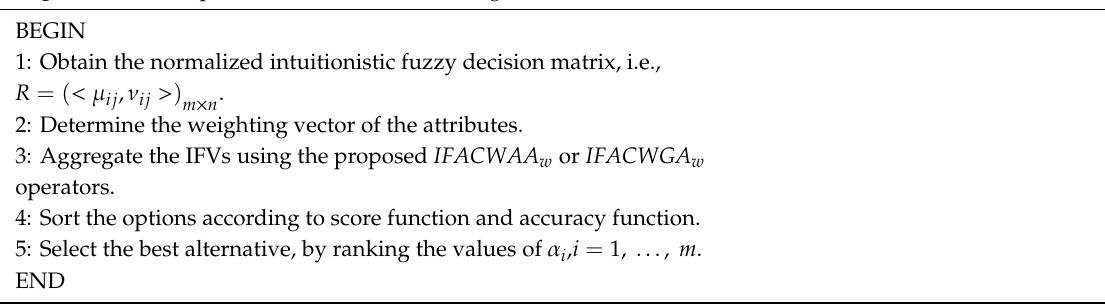
Algorithm 1 Multiple Attribute Decision Making